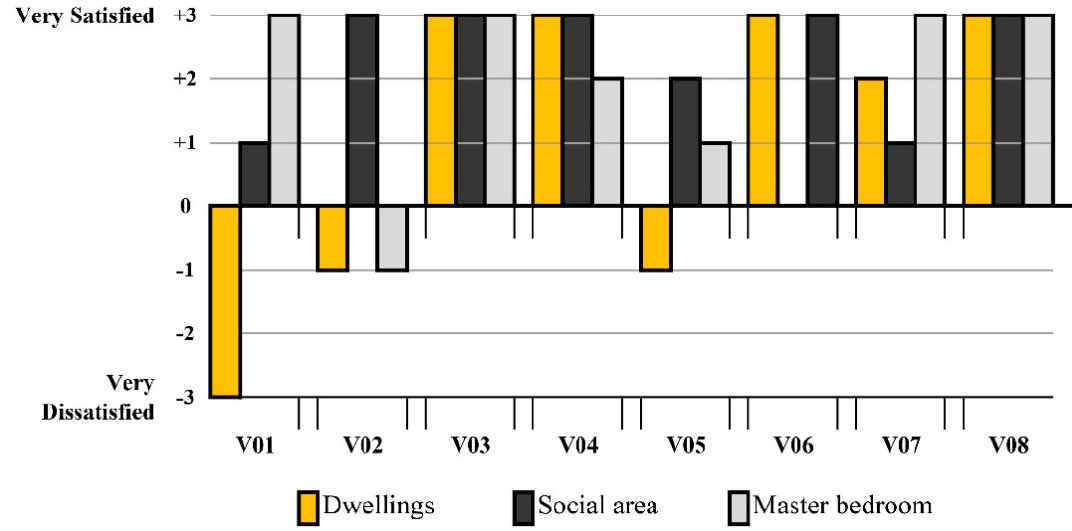
Figure 9. Comparison of air quality of the houses.